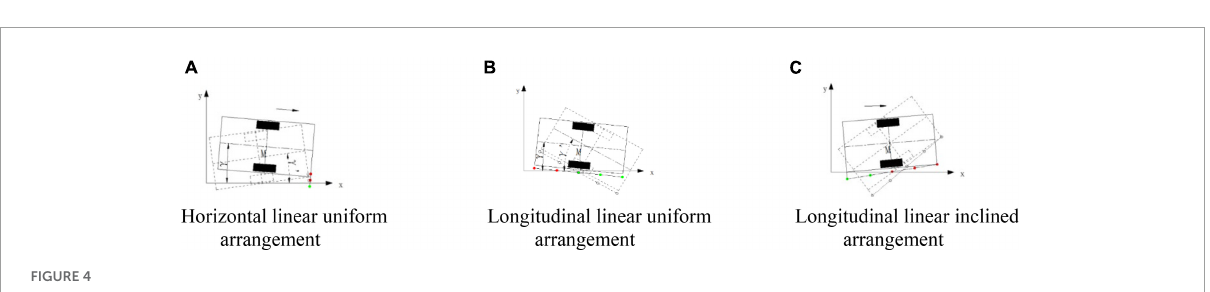
FIGURE4 A linear arrangement scheme of a photoelectric switch array: γ . The heading angle of the autonomous mobile platform relative to the road along.